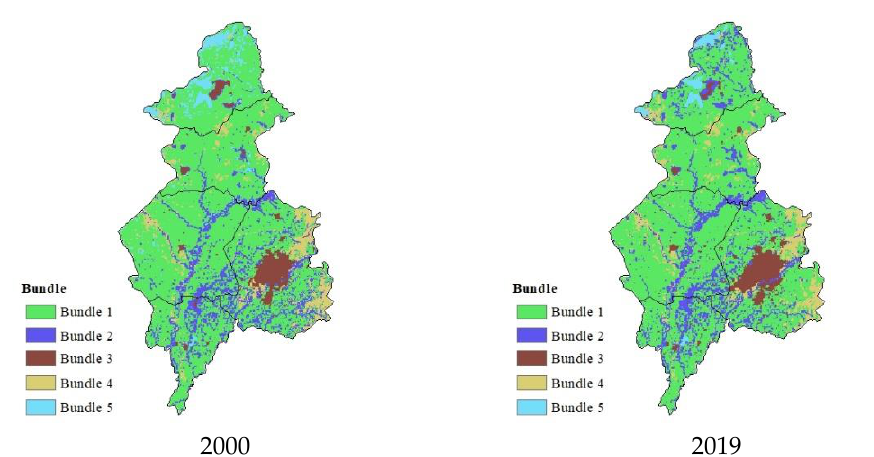
Figure 4. Spatial distribution of ES bundles in Shenyang.